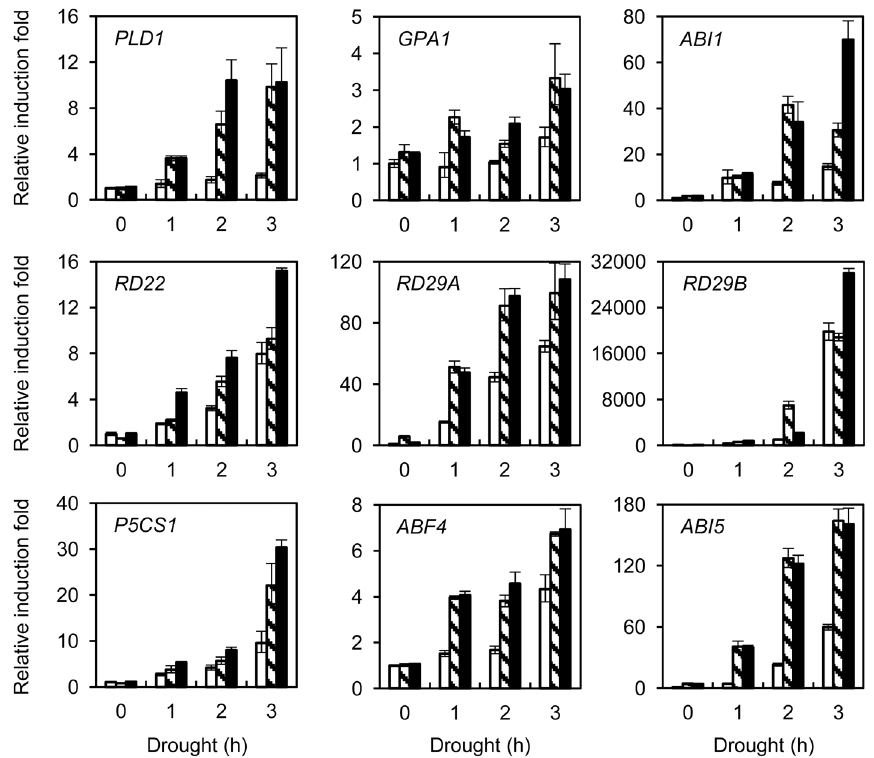
Fig 7. Expression of drought-stress-responsive genes in wild-type and GpDSR7- overexpressed Arabidopsis . Total RNA was extracted from control and drought-treated plants and the expression of several drought-responsive gene was analysed by qRT-PCR. The mean value of three technical replicates was normalised to the expression level of glyceraldehyde-3-phosphate dehydrogenase (GAPDH). Blank columns: control group; slash columns: #1 transgenic plants; black columns: #2 transgenic plants.